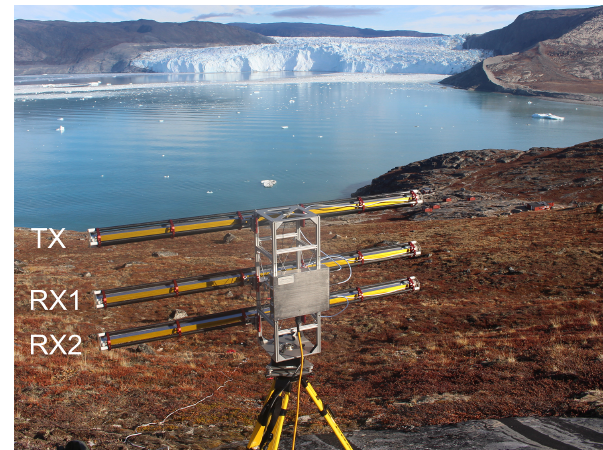
Figure 1. Overview of Eqip Sermia and measurement sites. The po- sitions of the terrestrial radar interferometer (TRI), the pressure sen- sor (PS), and the two weather stations (AWS) are indicated by trian- gles. The deep and shallow calving front sectors are marked with red and blue lines. Background: Sentinel-2A scene from 3 August 2016 (from ESA Copernicus Science Hub: https://scihub.copernicus.eu, last access: 14 August 2017).